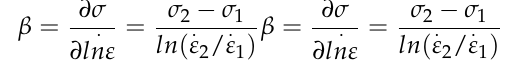
Figure 10. Stress–strain curves for the same specimen at different strain rates. ( a ) Group Z specimens (deposition direction). ( b ) Group X specimens (scanning direction).